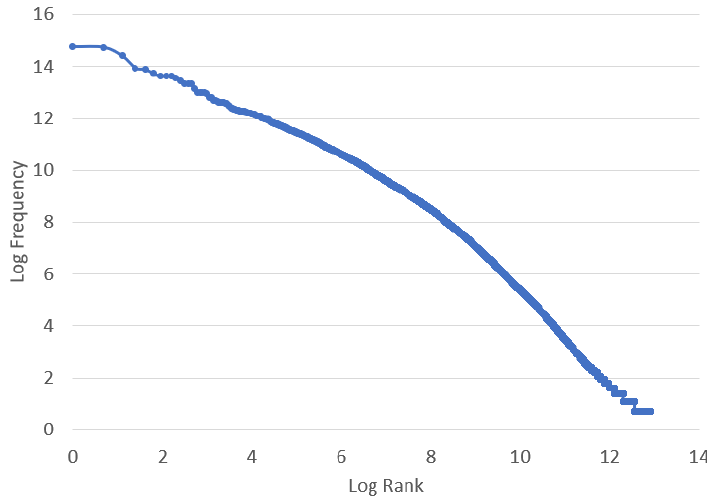
Figure 4. Zipf curves for the Indonesian corpus (650 K).